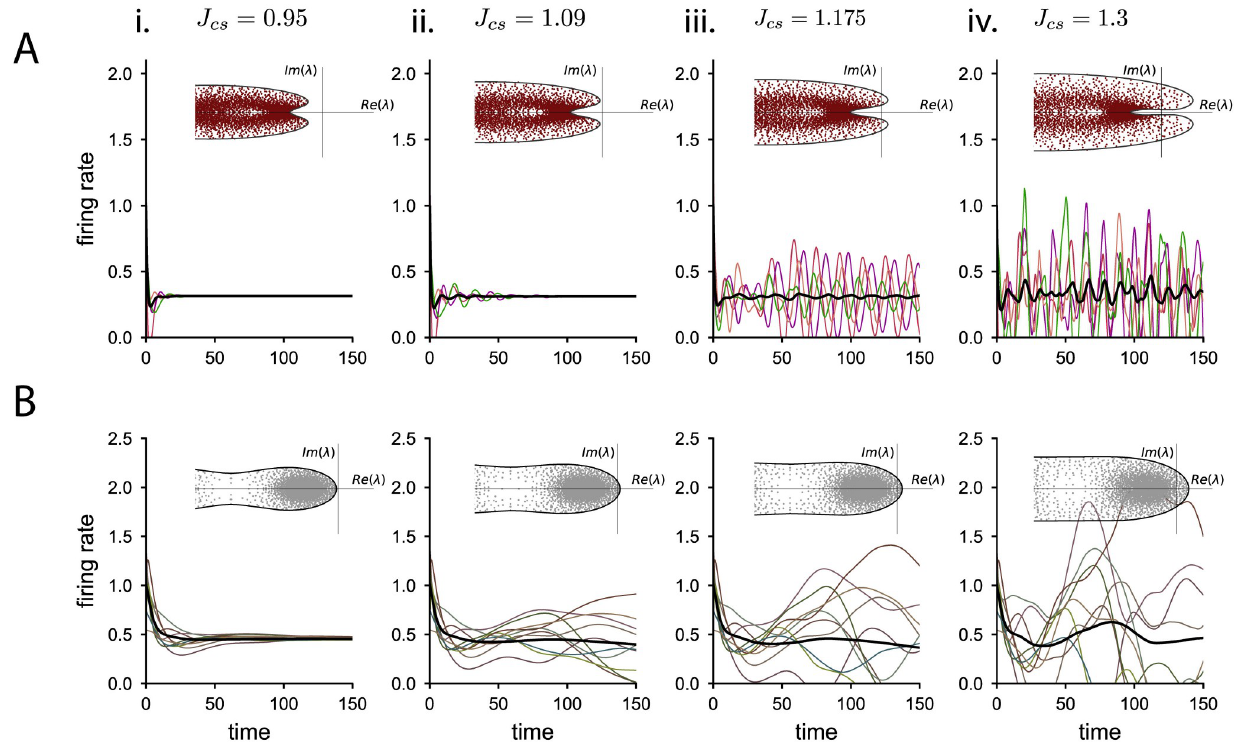
Fig 3. Dynamical regimes as the coupling strength is increased. Numerical integration of the dynamics for the network with adaptive neurons (row A) and the network with synaptic filtering (row B), as the coupling standard deviation J rates of individual neurons, the black line indicates the population average activity. Insets: complex eigenspectrum λ around the fixed point. Dots: eigenvalues of the connectivity matrix used in the network simulation. Solid line: theoretical prediction for the envelope of the eigenspectrum. The imaginary axis, Re( λ ) = 0, is the stability boundary. i. Both the network with adaptation and synaptic transmission are stable. ii. The network with synaptic filtering crosses the stability boundary and shows fluctuations in time and across neurons, while the network with adaptation remains stable. iii. The network with synaptic filtering displays stronger fluctuations. The network with adaptive neurons undergoes a Hopf bifurcation leading to strong oscillations at a single frequency with uncorrelated phases across units. Note in the inset that for this connectivity matrix there is only one pair of complex conjugate unstable eigenvalues in the finite network. iv. The network with synaptic filtering shows strong fluctuations. The network with adaptation displays fluctuating activity with an oscillatory component. Parameters: in A, g